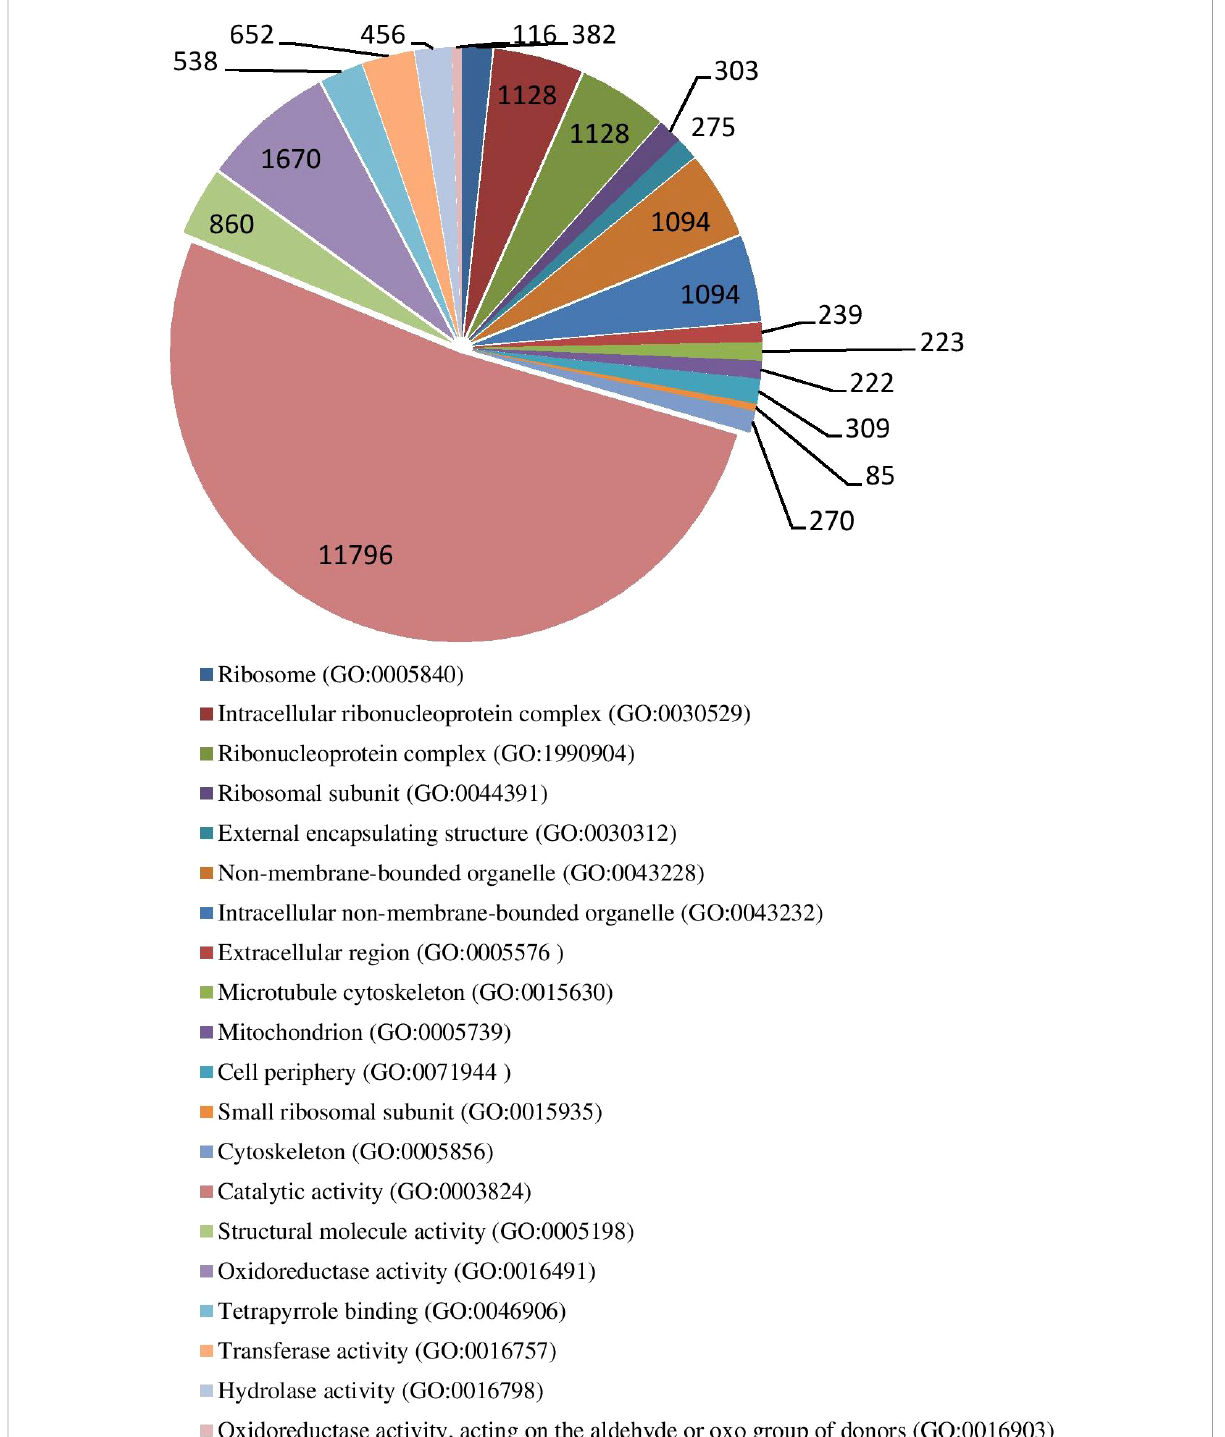
FIGURE 9 Gene ontology numbers indicated in signi fi cant GO IDs in all